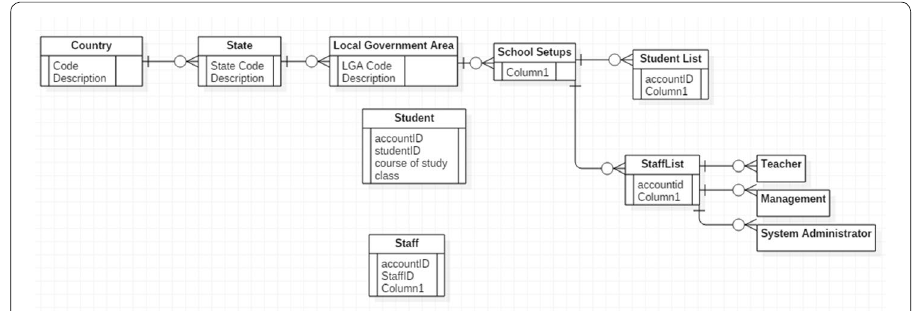
Fig. 10 E-R Diagram of the Collocation Data Model of a Group of